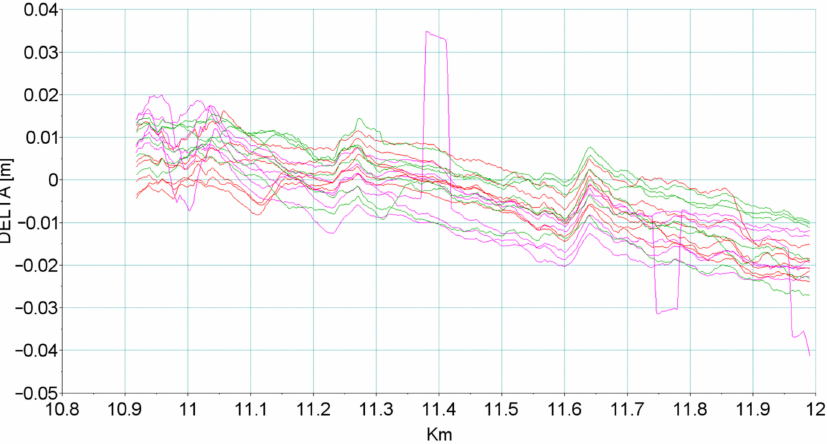
Figure 11. Deviations of the reconstructed track axis in horizontal plane for particular measuring instruments with respect to static measurement.